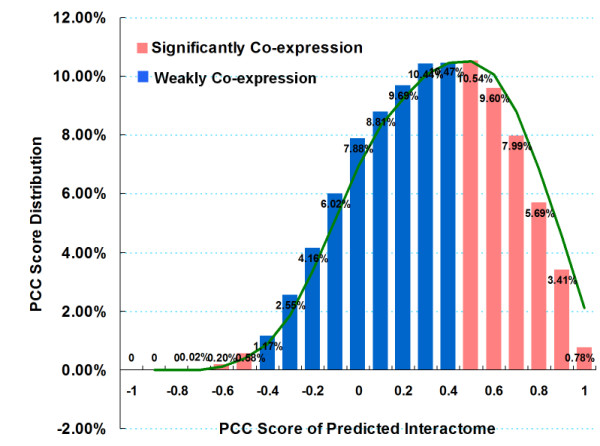
Co-expression PCC scores distribution. Pearson Correlation Coefficient score (see methods) is calculated to measure the correlation of two genes expression level of protein pairs in PRIN. Our results show an aggregation in PCC score between 0.3 and 0.8. With cut off 0.5, we finally obtained 28.3% of co-expressed protein pairs in PRIN, which farly exceeds a random level of 2.3% (see Discussion).